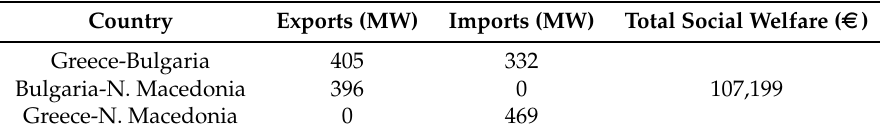
Table 1. Cross-border flows via the ATC method for the 3 country scenario.